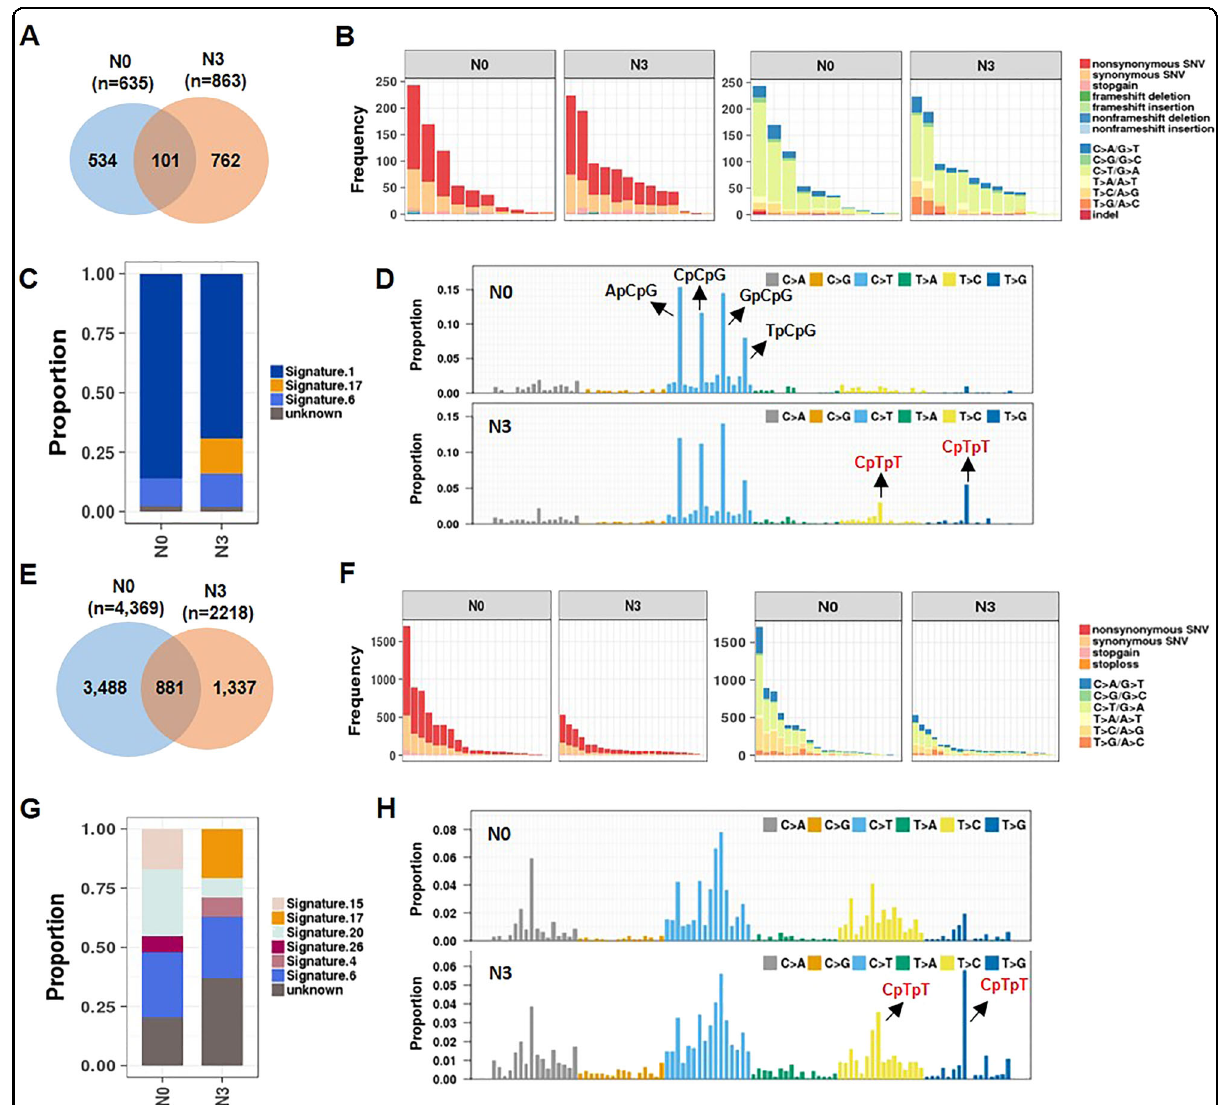
Fig. 3 Mutational spectrum of somatic mutations in DGC. a , e Venn-diagram showing the number of mutated genes that were overlapped among the N0 and N3 groups in our DGC cohort ( a ) and TCGA cohort ( e ). b , f The distribution of the mutation types according to protein functions (top) and substitution types (bottom) in each of our DGC cohorts ( b ) and in each TCGA cohort ( f ) is shown. c , g Distribution of the mutation signatures, based on the published signatures from Sanger COSMIC. The contributions of each mutation signature of N0 and N3 tumors in our DGC cohort ( c ) and in the TCGA cohort ( g ) are shown. d , h The distribution of triple nucleotides at the mutation fl anking site of N0 and N3 tumors in our DGC cohort ( d ) and in the TCGA cohort ( h ) is shown. The represented triplet nucleotides are indicated as